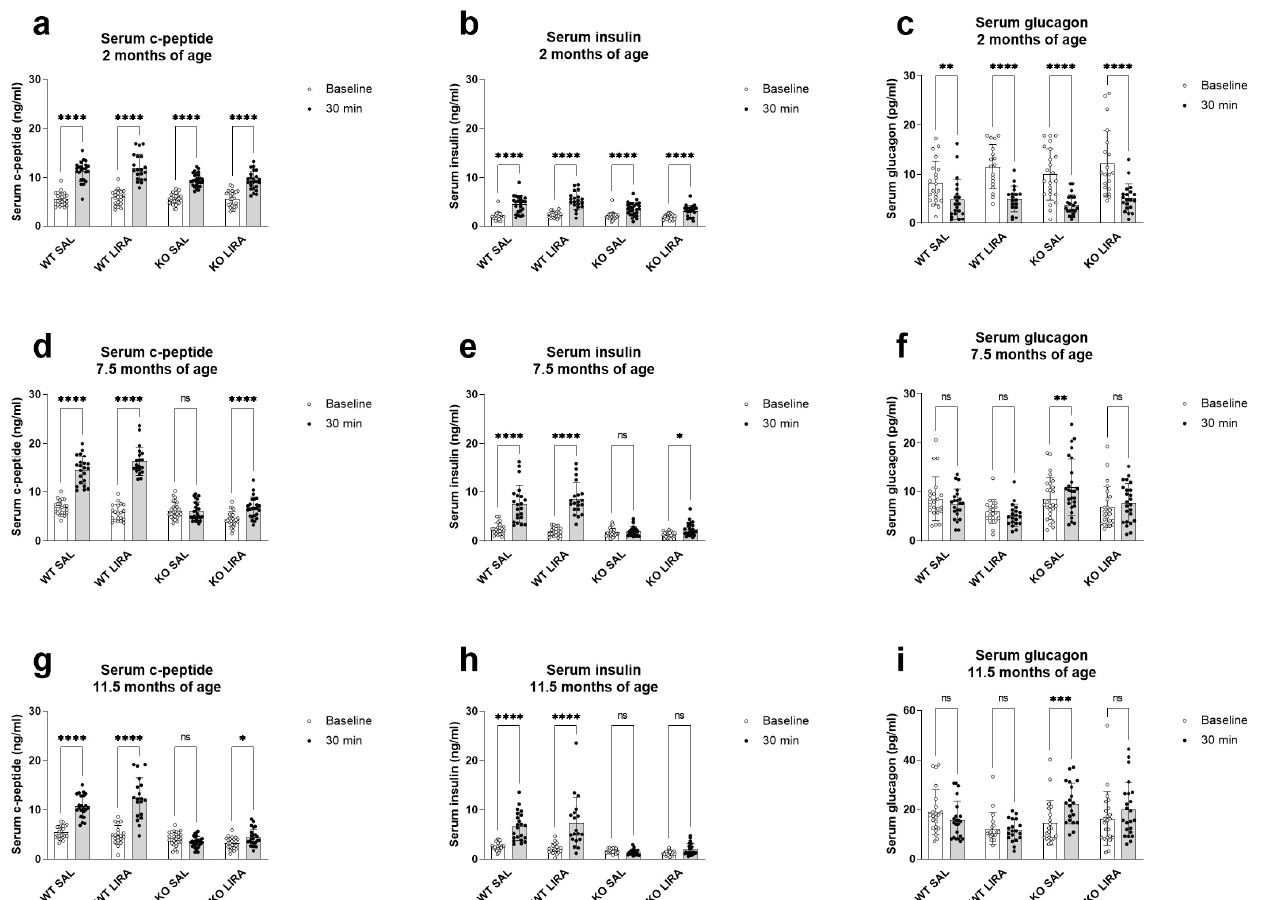
Figure 2. Prolonged treatment with liraglutide maintains c-peptide secretion until the age of 11 months and thereby delays the development of diabetes in a rat model of Wolfram syndrome. At the age of 2, 7.5 and 11.5 months, serum ( a , d , g ) c-peptide, ( b , e , h ) insulin and ( c , f , i ) glucagon levels before and 30 min after administration of glucose in the glucose tolerance test (IPGTT). ( a – c ) At the age of 2 months, there were no differences between experimental groups. At the age of 7.5 months, Wfs1 KO rats show the first signs of diabetes, i.e., reduced ( d ) c-peptide and ( e ) insulin levels, and increased ( f ) glucagon levels after glucose administration. Liraglutide treatment prevented these changes and at the age of 11.5 months, liraglutide-treated Wfs1 KO rats were still able to secrete ( g ) c-peptide. The data were compared using repeated measures ANOVA followed by Bonferroni’s multiple comparisons test. The data are presented as the mean ± SEM, non-significant (ns), * p < 0.05, ** p < 0.01, *** p < 0.001, **** p < 0.0001, n = 20–27 per group.